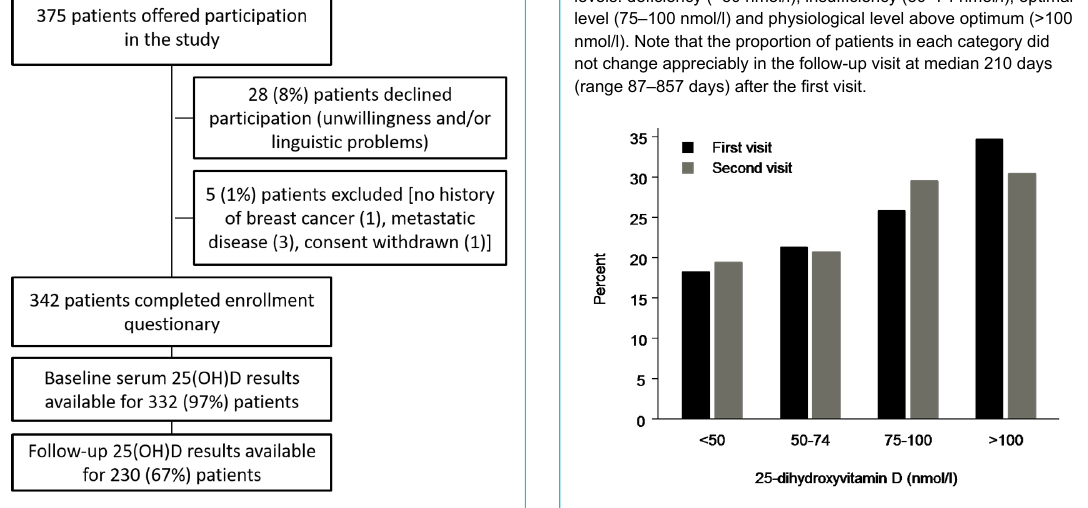
Figure 1: Patient recruitment, reasons for exclusion and dropouts.